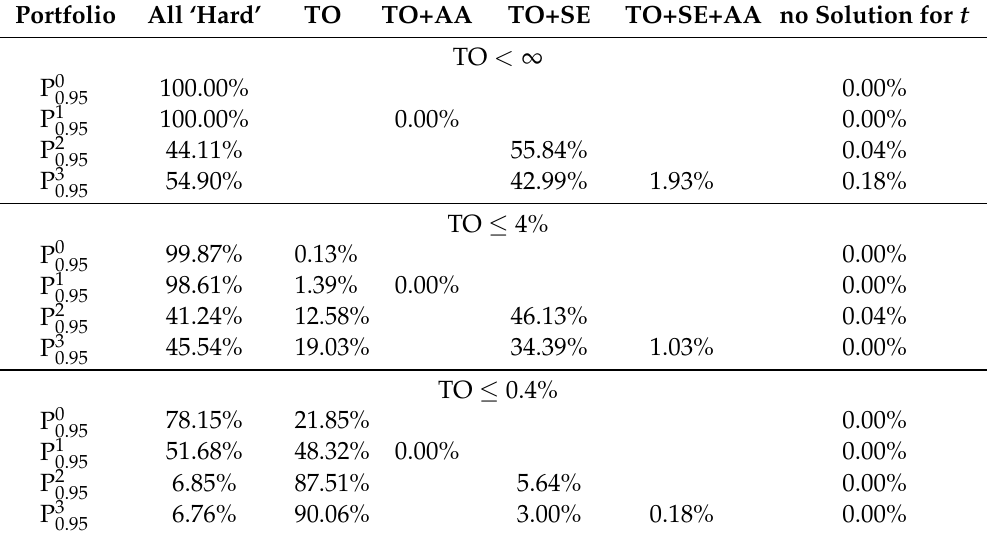
Table 2. Frequency of conversion of hard constraints to penalty